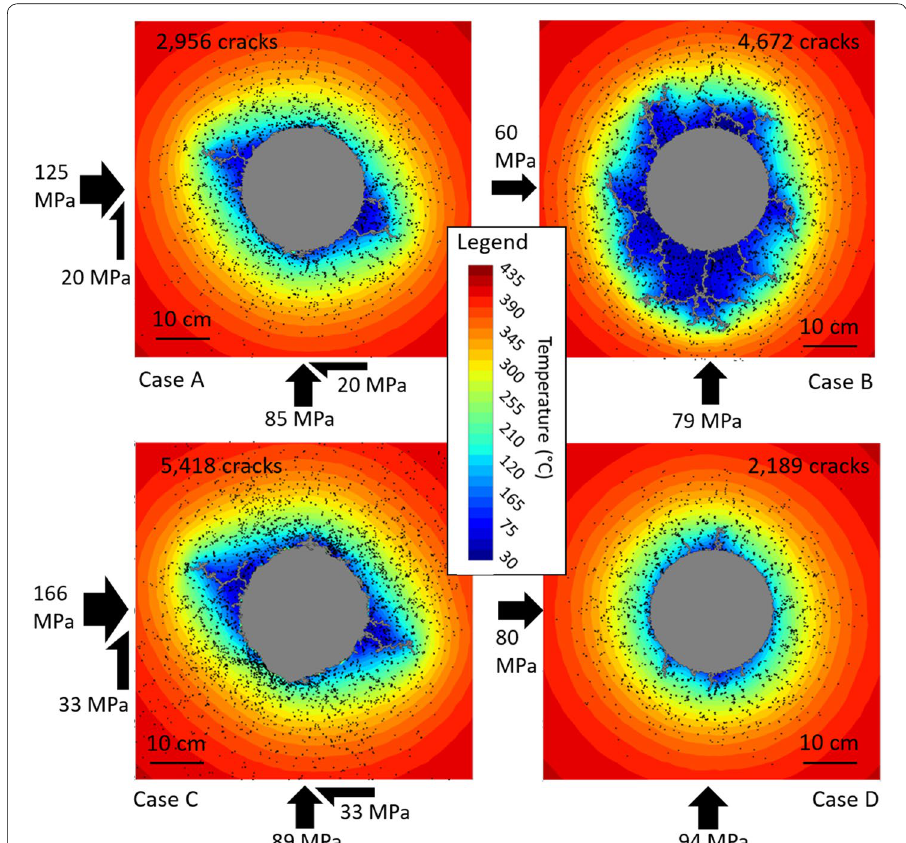
Fig. 15 Calculation results after 4 h of thermal loading for a heat transfer coefficient value of 1000 W m − 2 K − 1 (low thermal flux). The front color corresponds to the temperature (see legend). Each point corresponds to a crack (either tensile or shear crack). Grey uniform color corresponds to the area connected to the wellbore (penetration of hydraulic pressure and of thermal